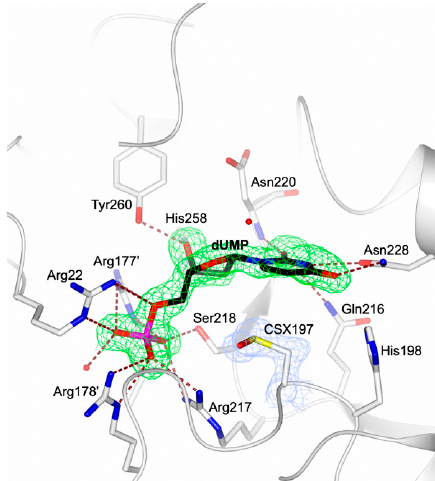
Figure 3. Active site view of Ef TS (white cartoon and carbon atoms) in complex with dUMP (in sticks, black carbon atoms). In the panel, dUMP is surrounded by the omit map (green mesh) contoured at the 2.5 σ level. Key interactions (salt bridges, hydrogen and halogen bonds) are displayed as tan dashed lines. The catalytic cysteine is oxidized to sulfenic acid (S-oxycysteine, CSX197), surrounded by the 2Fo-Fc map (blue mesh, contoured at the 1.5 σ level).